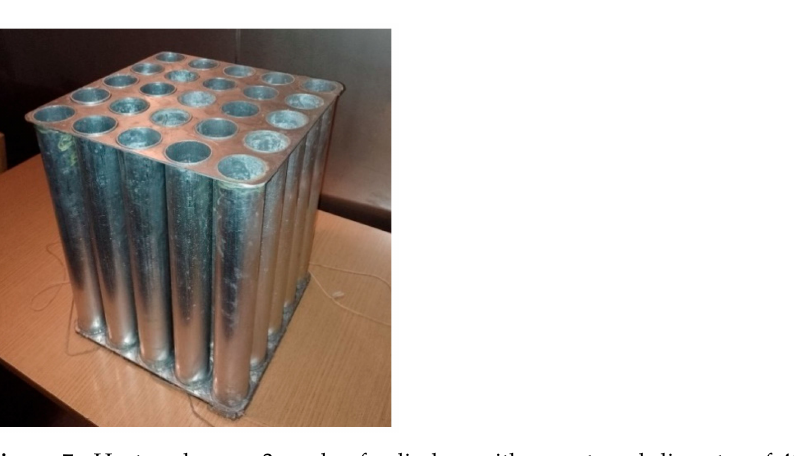
Figure 7. Heat exchanger 3 made of cylinders with an external diameter of 40 mm and a wall thickness of 1